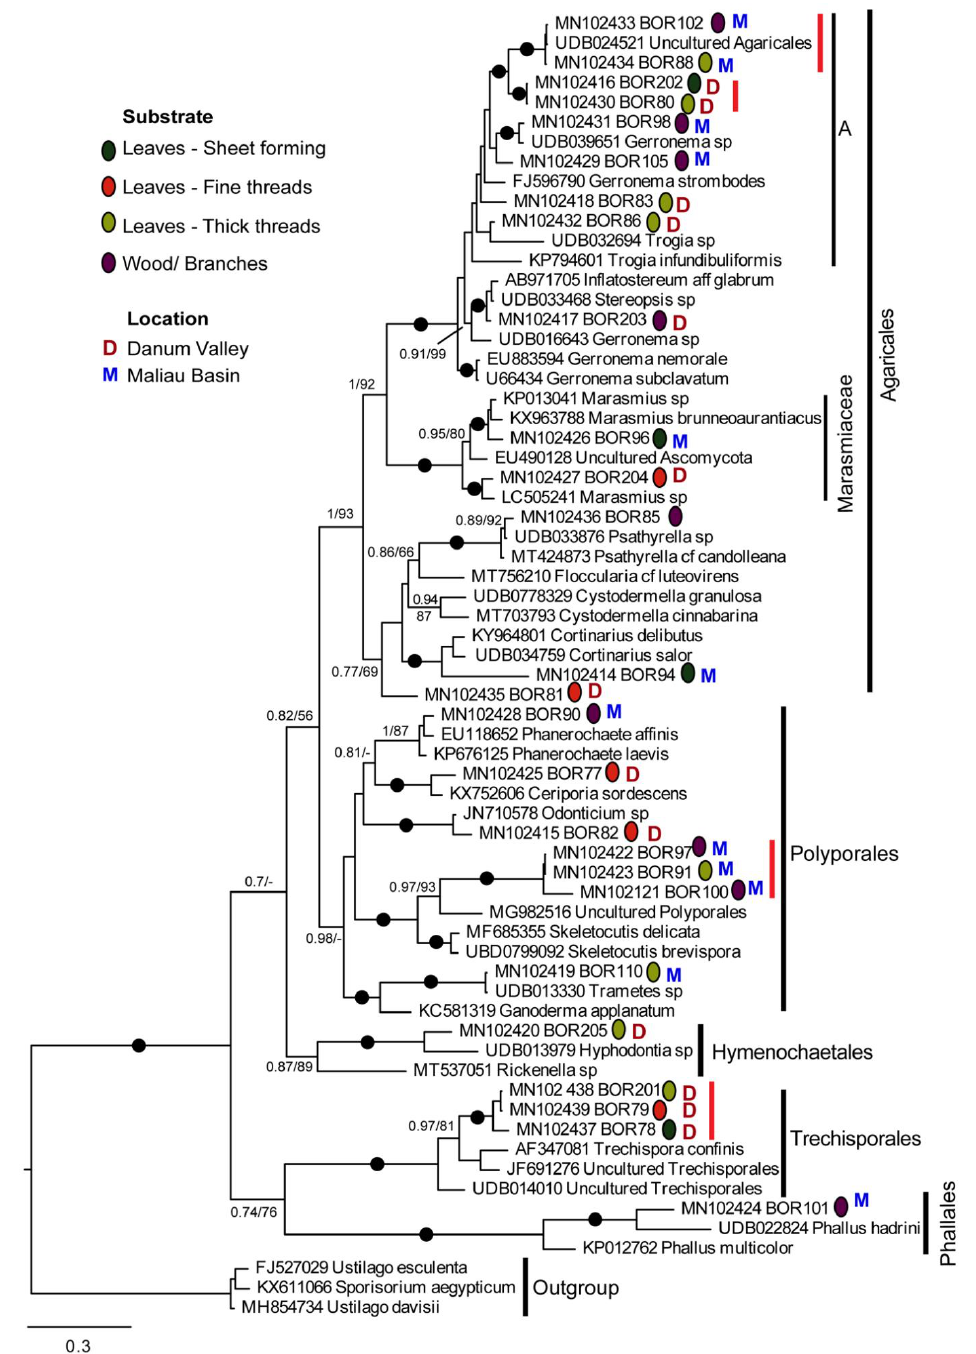
Figure 3. Bayesian phylogenetic tree of the ITS1-LR21 amplicon (3 (cid:48) of 18S to 5 (cid:48) of 28S rRNA genes). Sequences generated in this study are indicated by ‘BOR’. Vertical red lines indicate very similar BOR sequences that likely represent the same species. The analysis is intended to show the relationship of the BOR sequences to their closest relatives in GenBank and UNITE, as well as their ordinal affiliations, and is not appropriate for inferring higher level fungal relationships. Filled black circles indicate where both the Bayesian posterior probability (BPP) and maximum likelihood bootstrap (BS) support are above 0.95 and 95%, respectively. Other support values are given for nodes where BPP > 0.9 and/or BS > 75%. Supports are indicated in the order BPP/BS. ‘-’ indicates node not recovered by the method